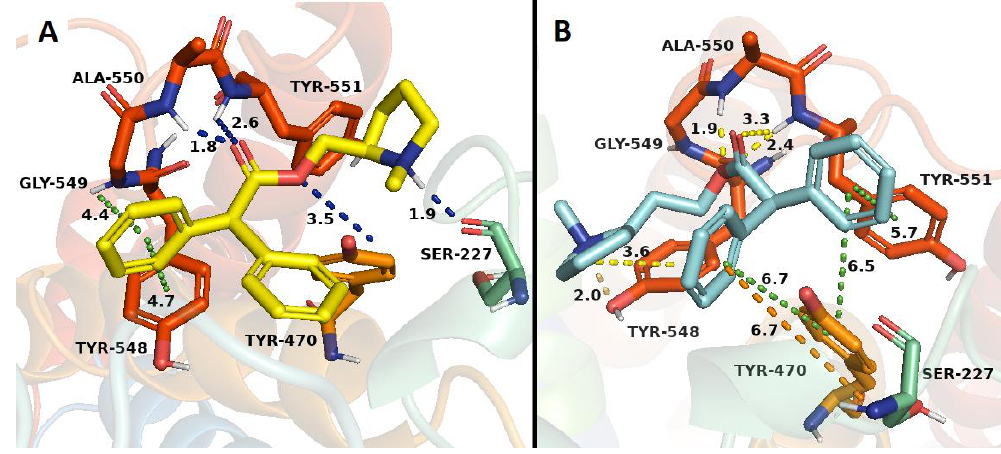
Figure 9. Binding modes of compounds 20 ( A ) and 21 ( B ) to the human DAT. The yellow ligand denotes compound 20 and the cyan ligand corresponds to compound 21 . Dotted lines correspond to the different interactions taking place in the ligand-receptor complexes.